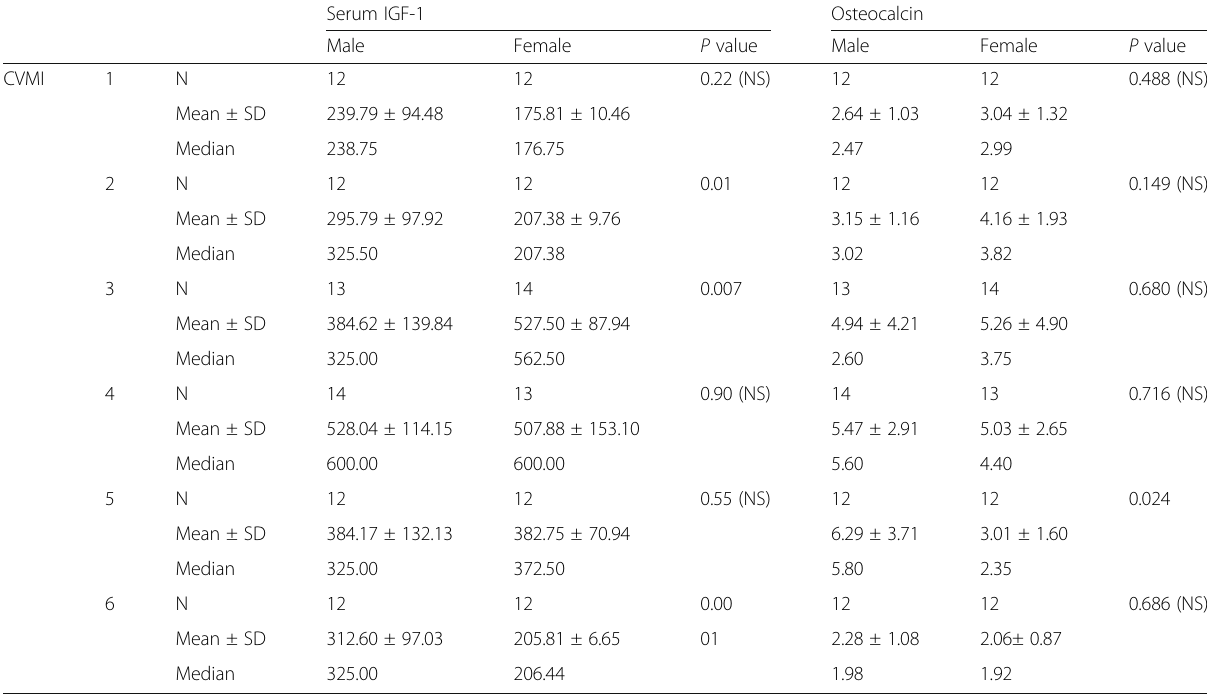
Table 4 Mann-Whitney test for the comparison of serum IGF-1 and osteocalcin between different CVMI stages of males and females along with the P